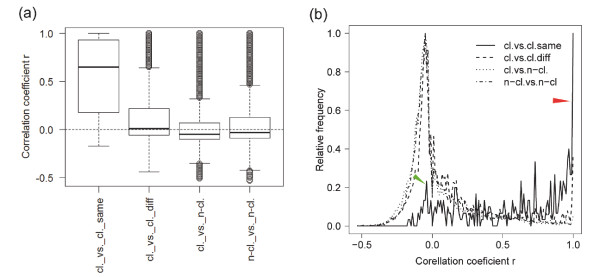
miRNAs with similar expression profiles mainly belong to the same clusters. (a) Pearson correlation coefficients r of expression profiles for miRNA pairs from the same cluster (cl.vs.cl.same), different clusters (cl.vs.cl.diff), clustered and non-clustered miRs (cl.vs.n-cl), and non-clustered miRNAs (n-cl.vs.n-cl.). (b) Frequency distributions of r in the same groups of miRNA pairs. Red and green arrows indicate highly and low correlated fractions of the clustered miRNAs in cl.vs.cl.same group, respectively. Distributions were normalized to the maximum value of frequency in each group.